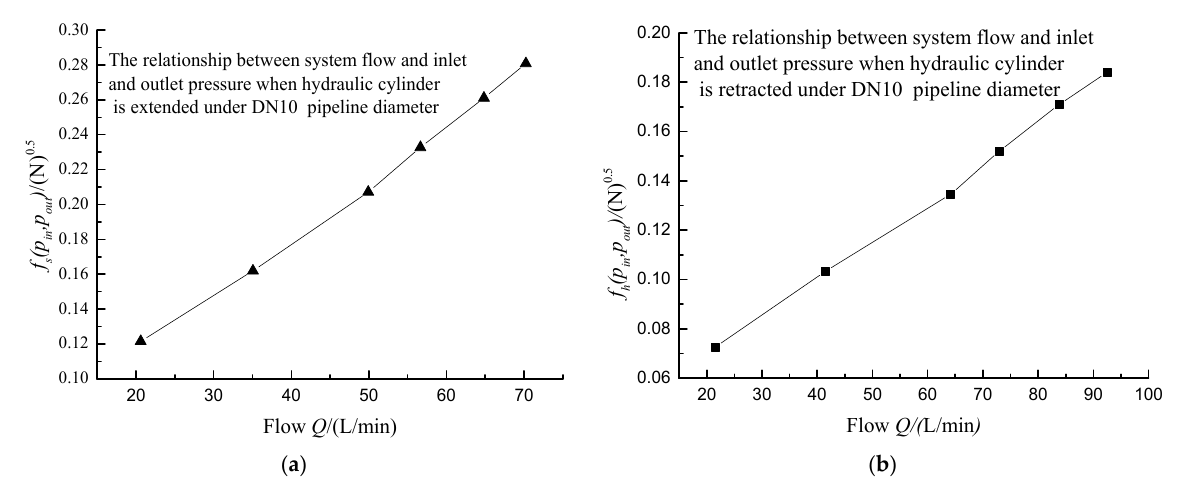
Figure 11. Relationship between flow and inlet and outlet pressure of hydraulic cylinder under DN10 diameter: ( a ) extended; ( b ) retracted.